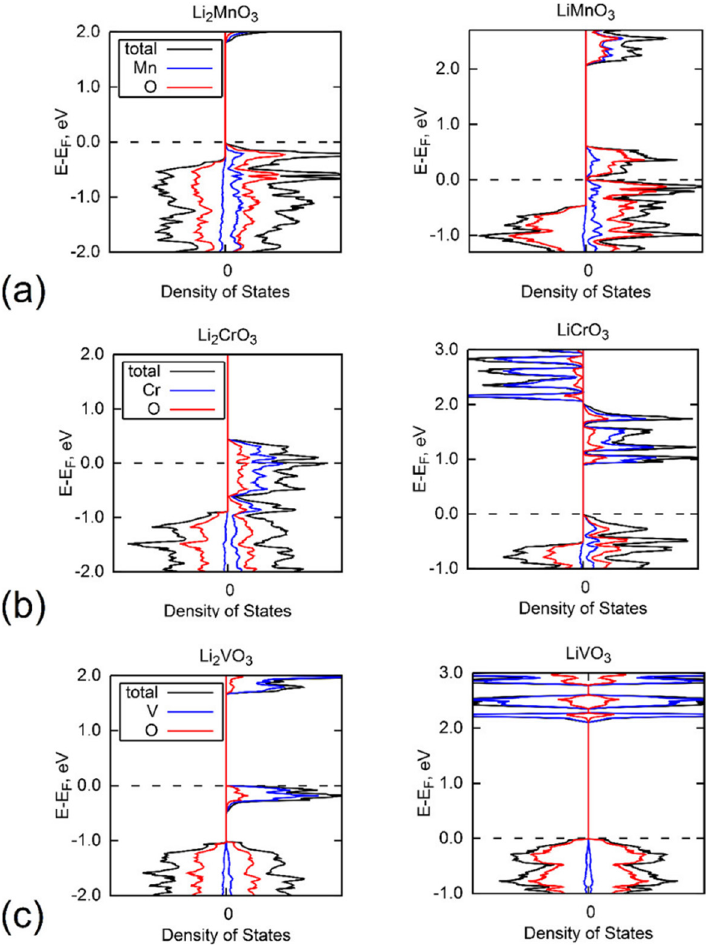
Figure 9. Calculated PDOS of ( a ) Li 2 MnO 3 /LiMnO 3 , ( b ) Li 2 CrO 3 /LiCrO 3 , and ( c ) Li 2 VO 3 /LiVO 3 . The total DOS is shown in black, the vanadium-projected one in blue, and the one for oxygen in red. The Fermi level is indicated by a dashed line and spin-up and spin-down DOS plotted as negative and positive values, respectively. Reprinted with permission from Ref. [24]. Copyright 2020 American Chemical Society.